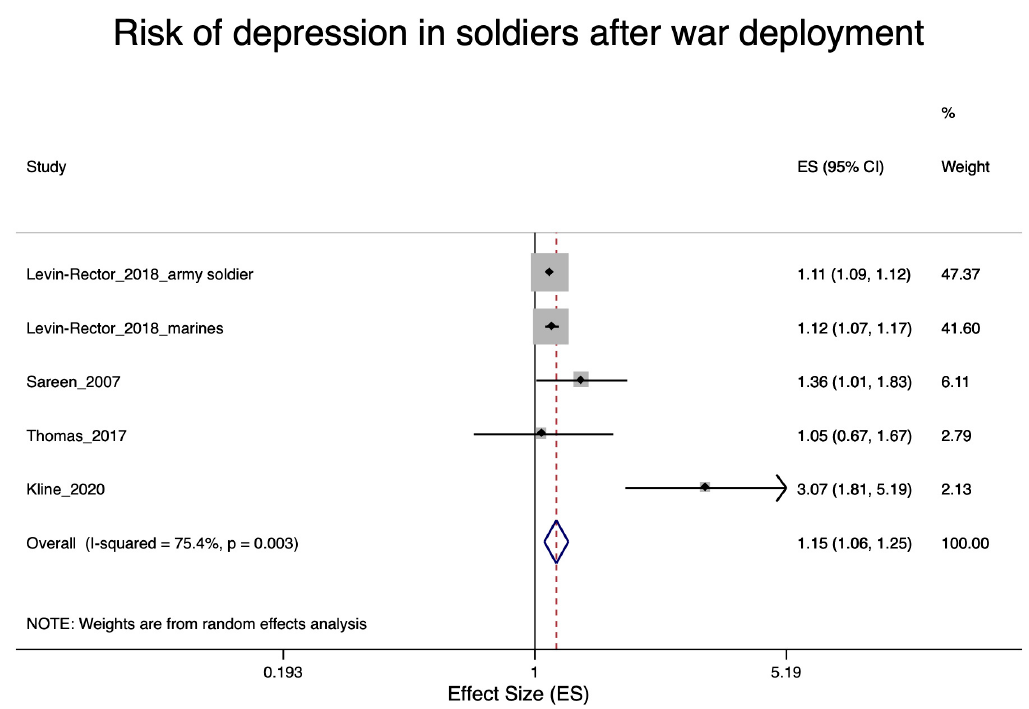
Figure 4. Forest plot of soldiers after war deployment and the estimates of effect size (ES) for depression.